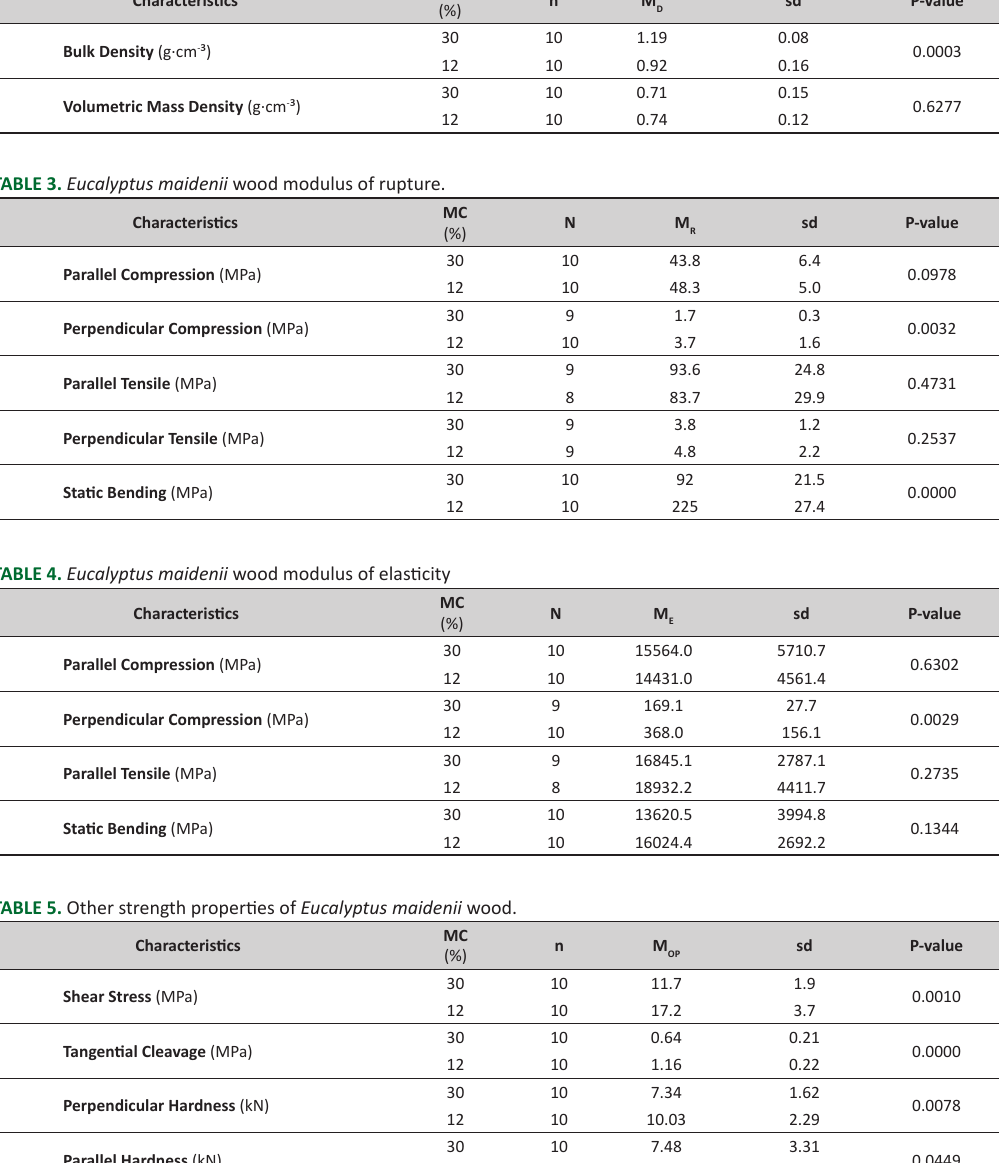
cleavage, perpendicular and parallel hardnesses, and tangential toughness of the studied Eucalyptus maidenii wood species. All listed tests were performed, revealing the successful obtaining of sixteen studied properties (Tables 2 to 5).